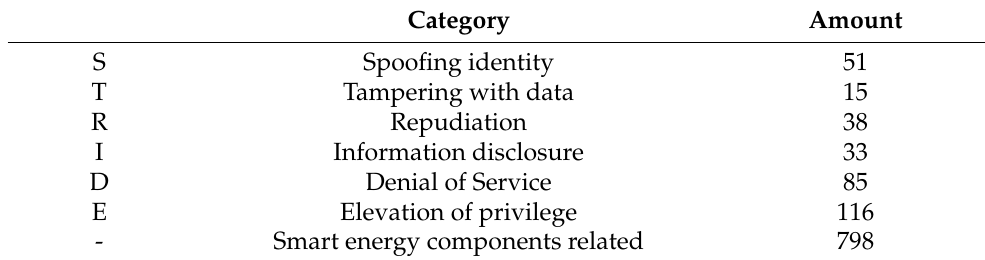
Table 1. Threat asignment to